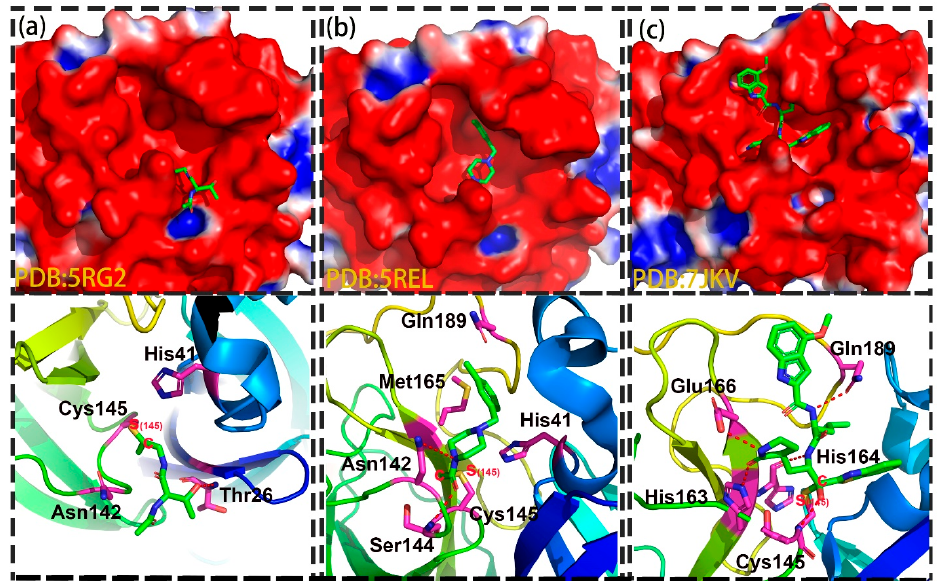
Figure 4. Three representative covalent inhibitors in the substrate-binding site of M pro . Three covalent binders are randomly selected from 3 groups. Bound compounds are depicted as cyan sticks and the surface of M pro is colored by potential on solvent accessible surface. The binding modes of 5RG2 ( a ), 5REL ( b ),7JKV ( c ).